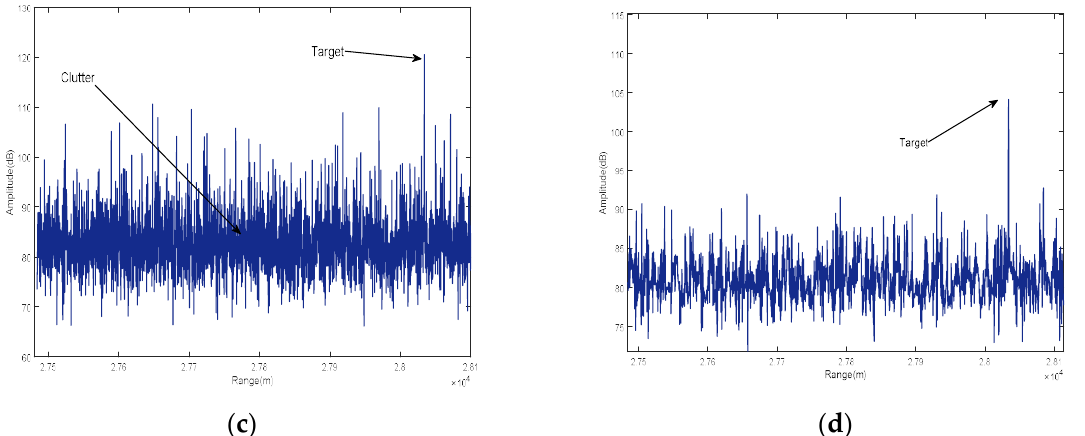
Figure 4. The simulated results of the clutter suppression: ( a ) echo after pulse compression (Gaussian noise alone); ( b ) echo after pulse compression (clutter and internal noise; ( c ) echo after 3DT; ( d ) echo after 3DT-WD.